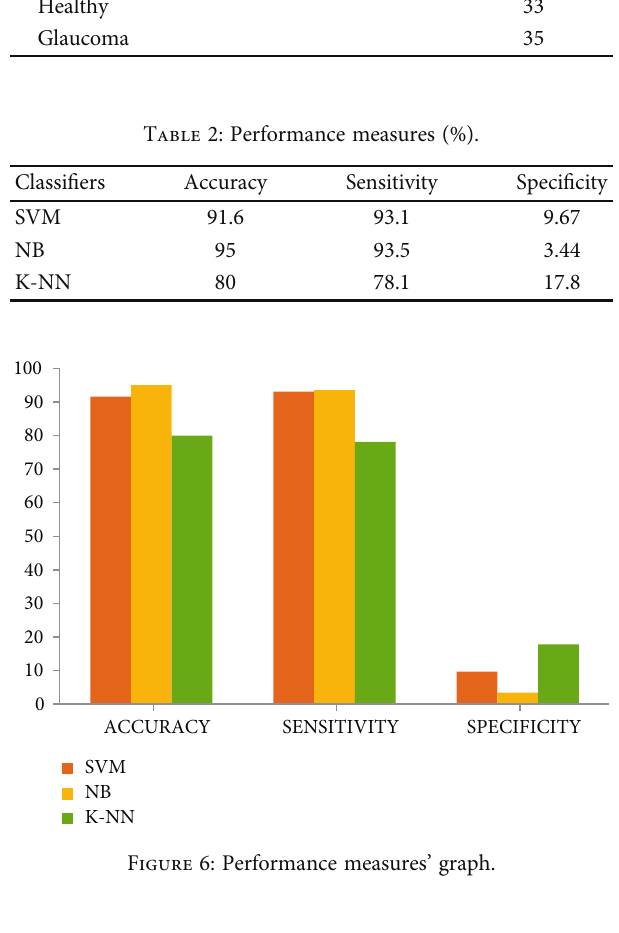
(iv) FN . The healthy input image is detected as a glau- coma image by the classi fi er